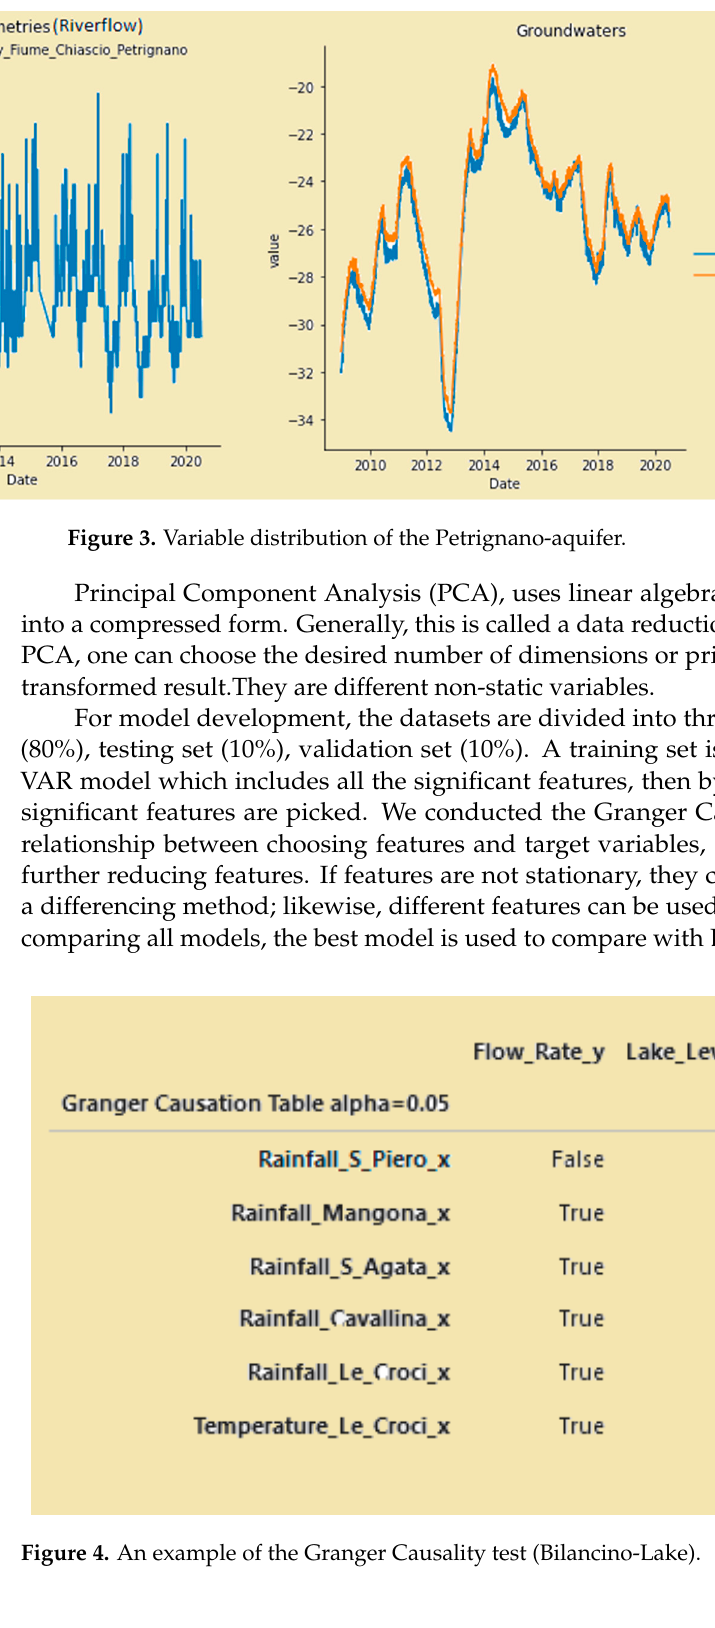
Figure 3. Variable distribution of the Petrignano-aquifer.